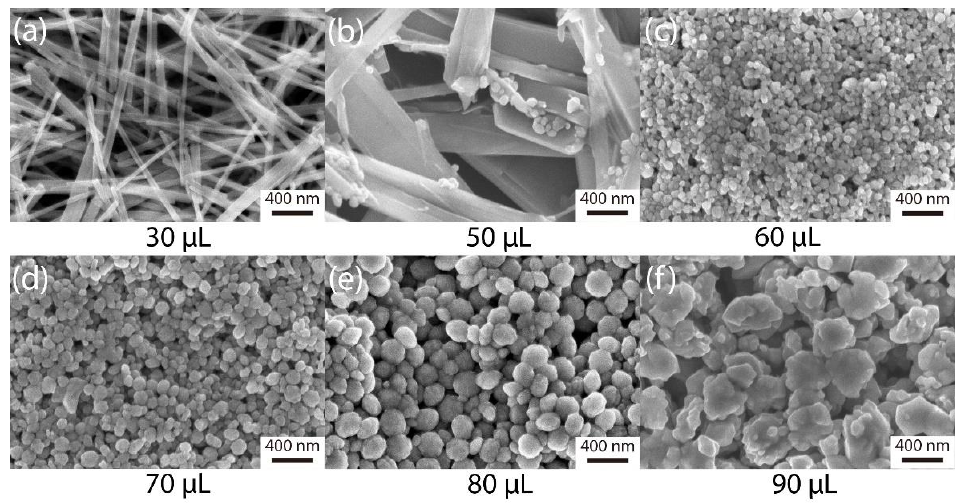
Figure 2. (a – f) SEM images of hydrothermal samples with different amounts of the reduction at 260 °C and 24 h duration.